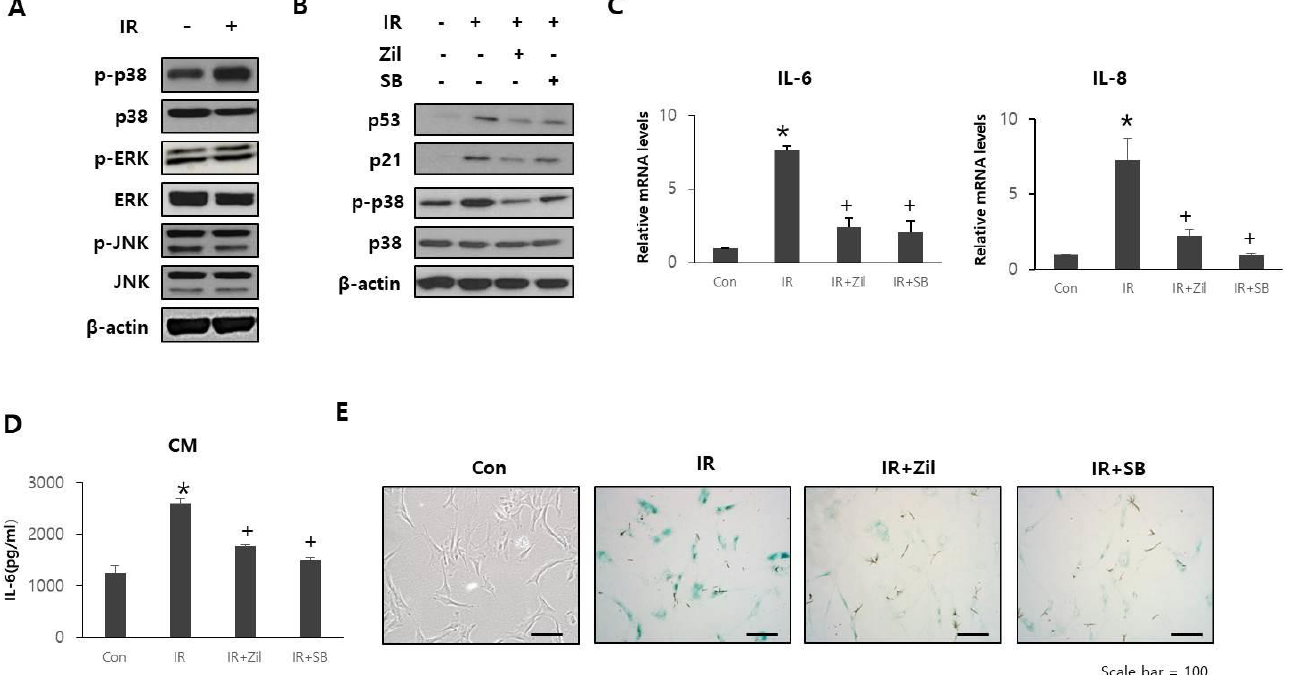
Figure 4. Effects of p38 inhibition on radiation-induced senescence. ( A ) HDF cells were exposed to 10 Gy radiation. After 24 h, levels of p-ERK, ERK, p-p38, p38, p-JNK, and JNK were assessed by Western blotting. ( B – E ) HDF cells were irradiated and further treated with zileuton (Zil) or SB203580 (SB). ( B ) p53, p21, p-p38, and p38 expression levels in HDFs. ( C ) IL-6 and IL-8 mRNA levels in HDFs. Data are presented as mean ± standard deviation, with statistical significance set at * p < 0.05 vs. control group (Con), + p < 0.05 vs. irradiated group (IR). n = 3; ANOVA (analysis of variance). ( D ) Secreted IL-6 levels in CM from HDFs. Data are presented as mean ± standard devi- ation. * p < 0.05 vs. control group (Con), + p < 0.05 vs. irradiated group (IR). n = 3; ANOVA (analysis of variance). ( E ) Representative SA- β -gal staining images in HDFs.